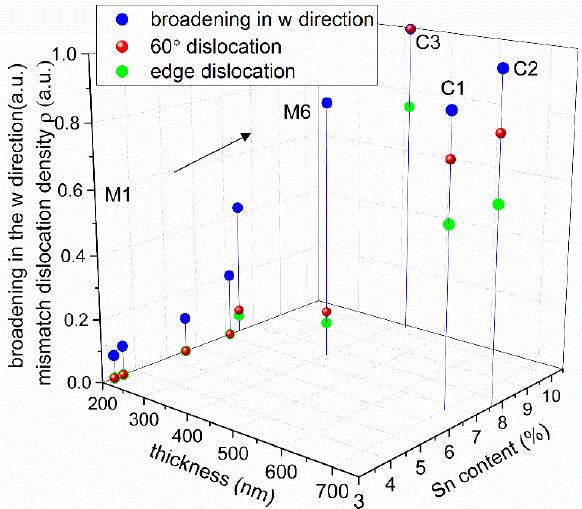
Figure A2. Normalized broadening in the ω direction (blue), and the dislocation density calculated based on all 60 ◦ dislocation (red) and all edge dislocation (green) assumption with di ff erent thicknesses and Sn